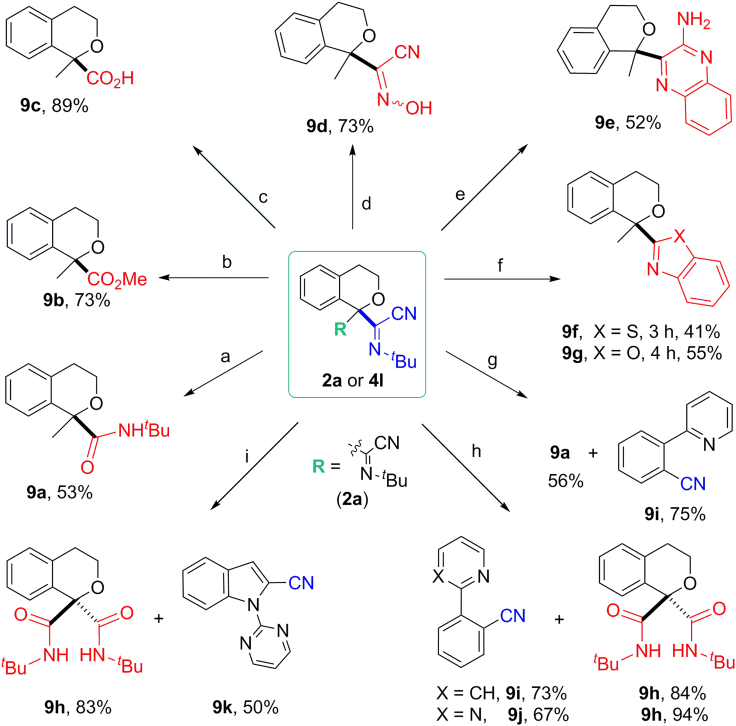
Synthetic applicationsReaction conditions: (A) Al2O3, toluene, 150°C, 25 h; (B) HCl, MeOH, room temperature, 10 h; (C) HCl, CH3CN, room temperature, 2.5 h; (D) NH2OH· HCl, K2CO3, EtOH, reflux, 4 h; (E) o-Phenylenediamine, AcOH, 120°C, 7.5 h; (F) 2-Amino-benzenethiol or 2-aminophenol, AcOH, 120°C; (G) 2-Phenylpyridine, Pd(OAc)2, Cu(TFA)2, THF, 120°C, 23 h; (H) 2-Phenylpyridine or 2-phenylpyrimidine, Pd(OAc)2, Cu(TFA)2, THF, 120°C, 23 h; (I) 1-(Pyrimidin-2-yl)-1H-indole, Pd(OAc)2, Cu(TFA)2, THF, 120°C, 23 h